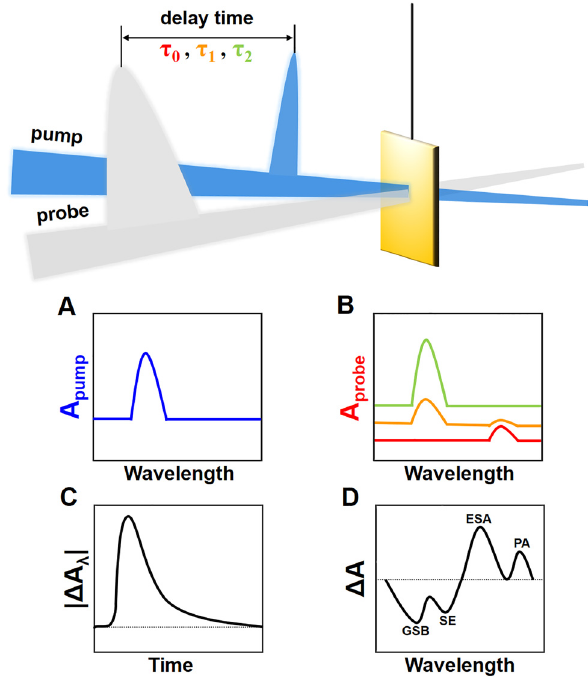
Figure 1: Basic mechanism of transient absorption (TA) spectroscopy. (A) ground state absorption spectrum, (B) excited state absorption spectrum, (C) TA pro fi le probed at a speci fi c wavelength, (D) four possible mechanisms contributing to the recorded TA